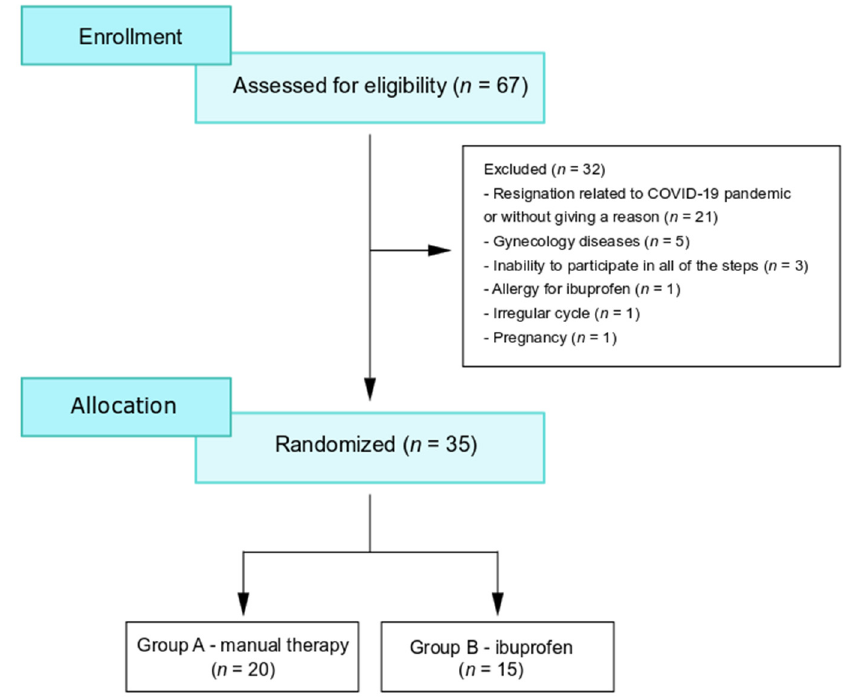
Figure 1. The enrollment of patients with primary dysmenorrhea.